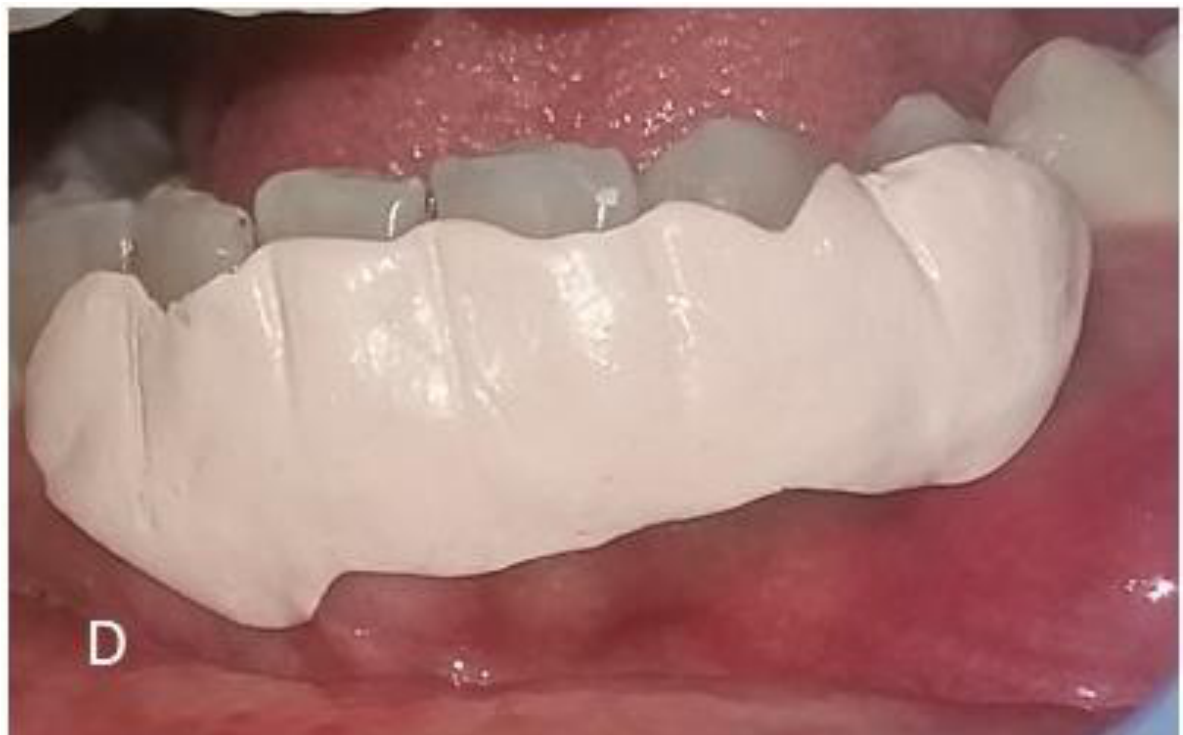
Figure 1. Clinical steps involved in the study. ( A ) Recording clinical parameters at baseline. ( B ) Subgingival plaque sample collection. ( C ) LDD at the site of Periodontal Pocket. ( D ) Placement of periodontal dressing.